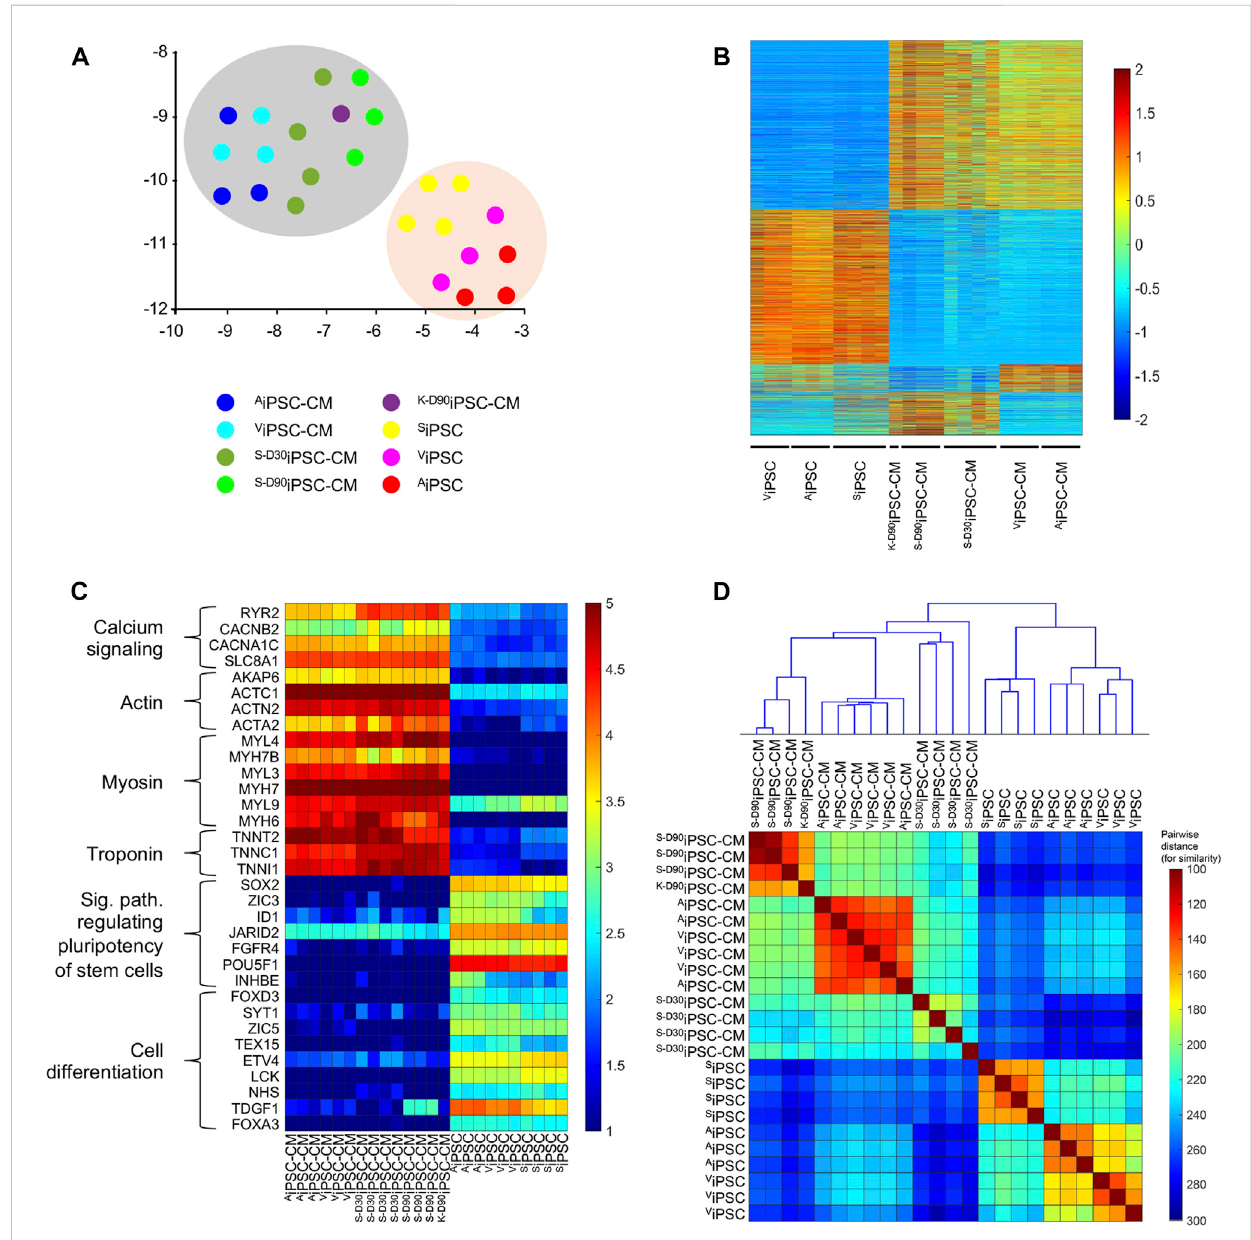
FIGURE 5 TranscriptionalanalysisofiPSCandiPSC-CMcelllines. (A) UMAPplot,wheretheentiregeneexpression(35,794genes)wasembeddedandreduced totwodimensions.Notethedifferenceinthetranscriptionalpro fi lebetweeniPSC-CM(greyshade)andiPSC(orangeshade). (B) Heatmapofdifferentially expressed genes ( p -value < 0.05) when comparing iPSC to iPSC-CM and among iPSC-CM from different origins. While a high number of differentially expressed genes were detected when comparing iPSC and iPSC-CM samples (4,970), a mild number was observed between A iPSC-CM/ V iPSC-CM and other iPSC-CM samples and almost non-signi fi cative differences were identi fi ed after comparing A iPSC-CM and V iPSC-CM (124). The colors represent the z-score normalization (gene expression magnitude is ignored). Red color denotes upregulation of transcripts, while blue denotes downregulation of mRNA levels. (C) Heatmap of selected gene to show the ef fi ciency of the iPSC-CM differentiation process. Calcium signaling, Actin, Myosin, Troponin, signaling pathway regulating stem cell pluripotency, and cell differentiation gene expression markers are differentially expressed among the iPSC-CM and iPSC cell lines. The colors represent the normalized expression via Deseq2 pathway to emphasize the expression magnitude of these genes. (D) Clustergram plot including a heatmap of pairwise Euclidian distance among the 24 studied samples and the cluster hierarchy among these. Note the small distance (high similarity) between A iPSC-CMs and V iPSC-CMs compared to the rest of the iPSC-CMs and